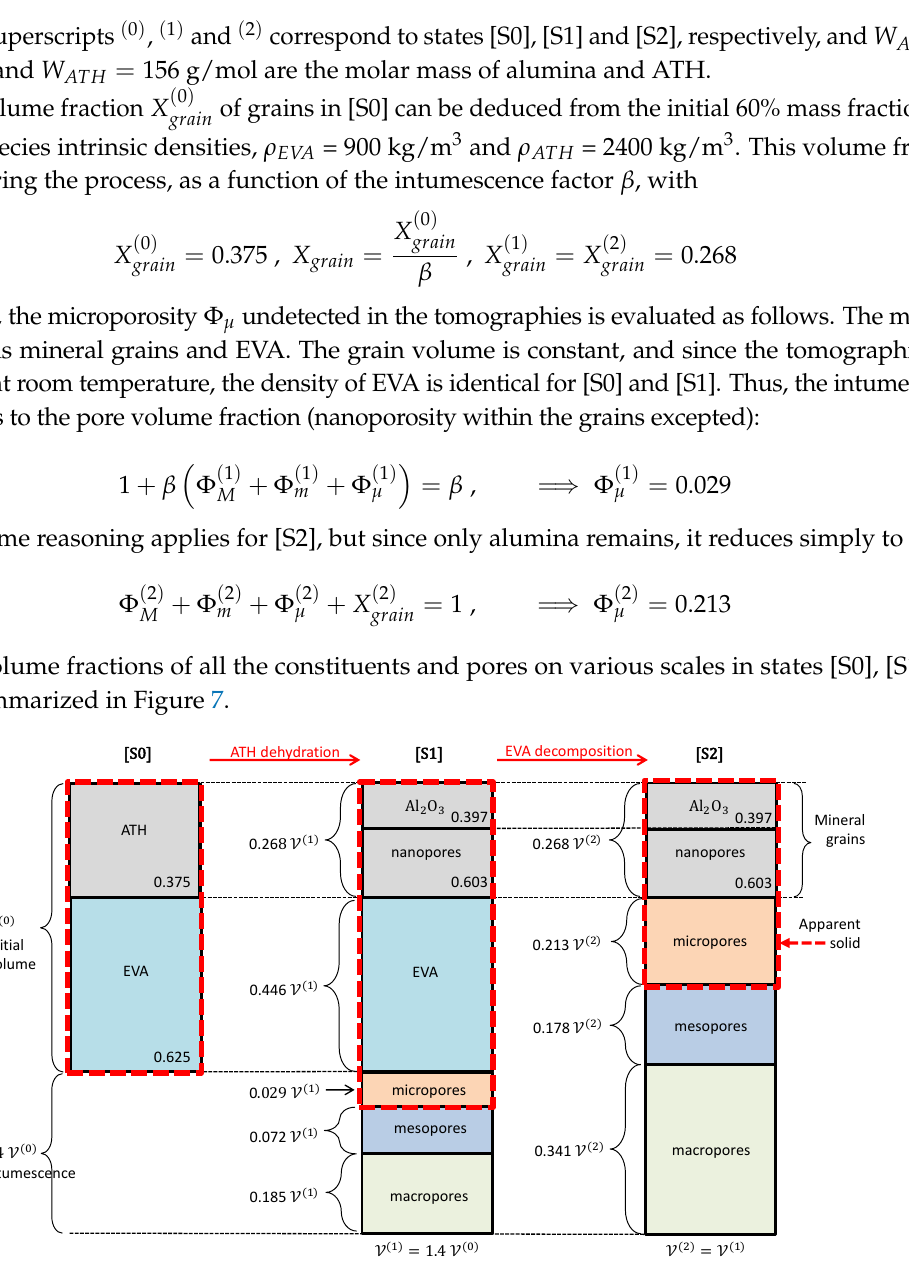
Figure 7. Volume fractions of the constituents and pores on various scales in states [S0], [S1] and